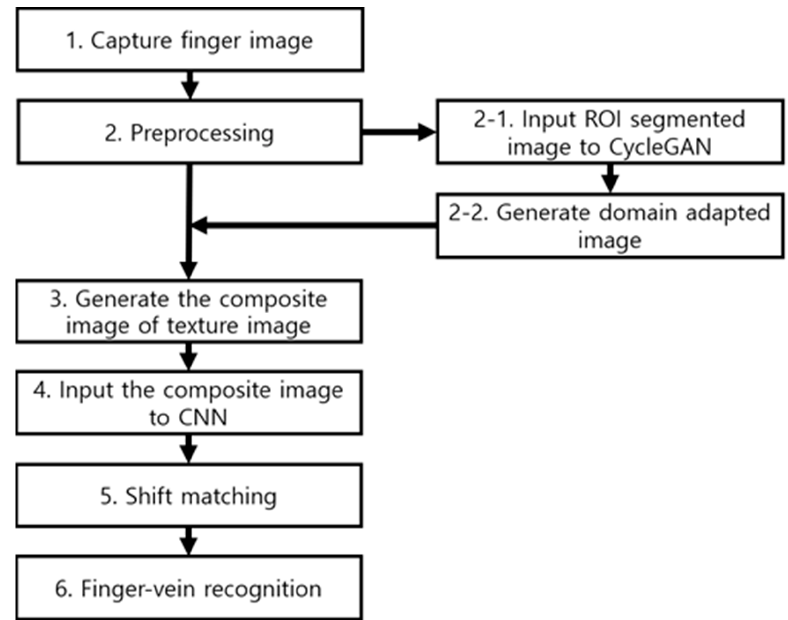
Figure 1. Overall procedure for the proposed finger-vein recognition method. background region. The image that has undergone binary thresholding is used as a mask of the original finger-image and then undergoes linear stretching to fit the input size of a CNN subsequently. The finger region is not stretched uniformly if burrs are present in the mask during linear stretching. Thus, boundary smoothing enables the finger region to be stretched uniformly, thus minimizing information